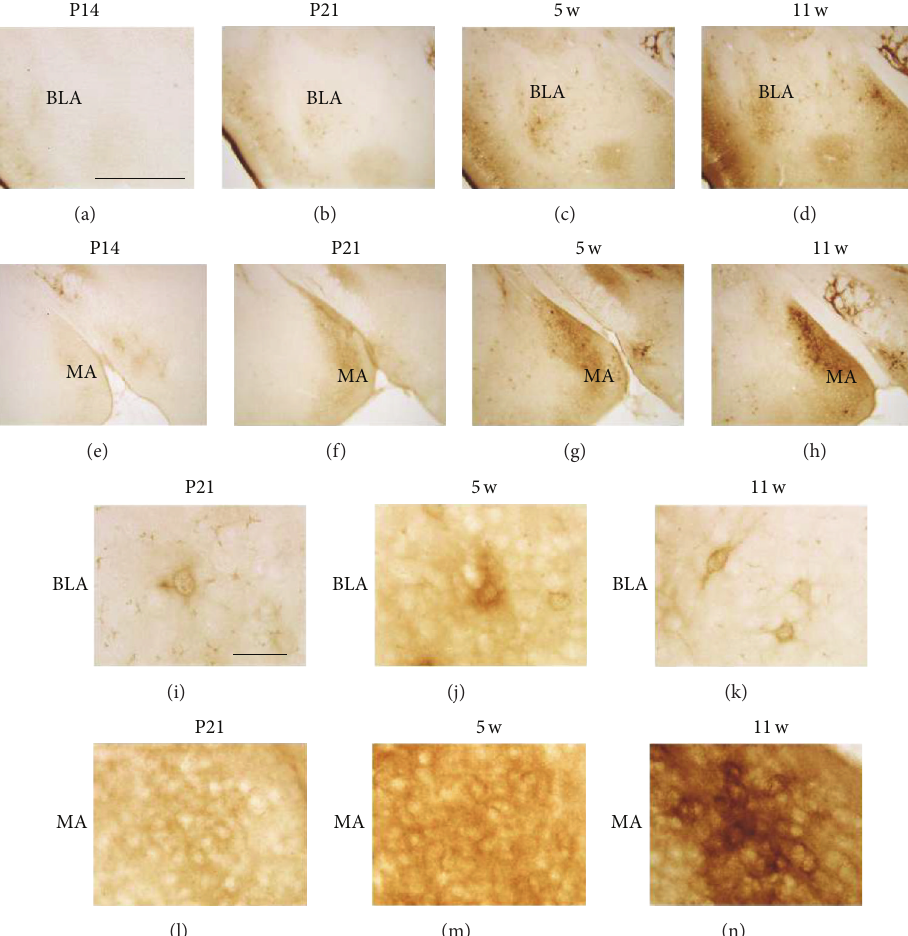
Figure 3: WFA-stained ECM in the developing amygdala. (a–h) WFA-labeled images in the BLA (a–d) and MA (e–h) at P14 (a, e), P21 (b, f), 5 w (c, g), and 11w (d, h). In both regions, WFA reactivity was observed from P21 onward. (i–n) Higher magnification images of the BLA (i–k) and MA (l–n) at P21 (i, l), 5 w (j, m), and 11w (k, n). Ambiguous PNN-like staining was observed in the BLA at P21 and 5 w,